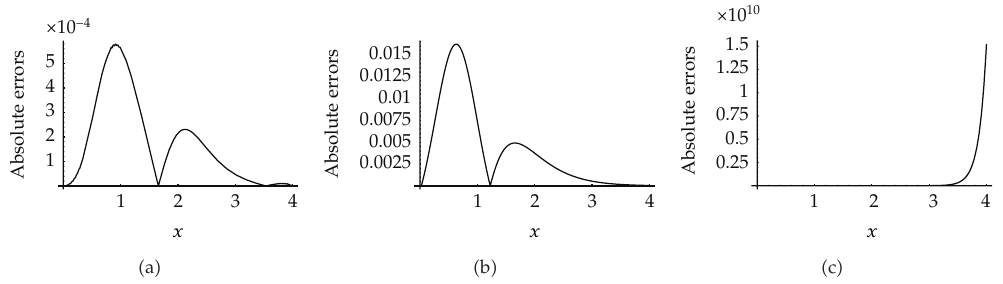
Figure 2: Comparison of absolute errors using the present method, MVIM (cid:7) 9 (cid:8) and VIM (cid:7) 6 (cid:8) for Example 4.1. (cid:3)(cid:3) a (cid:4) : The present method; (cid:3) b (cid:4) : MVIM (cid:7) 9 (cid:8) ; (cid:3) c (cid:4) : VIM (cid:7) 6 (cid:8)(cid:4)